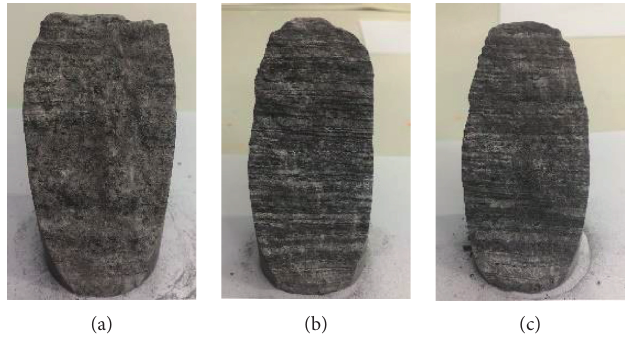
Figure 14: U-shaped fractures of dry phyllite specimens ( σ